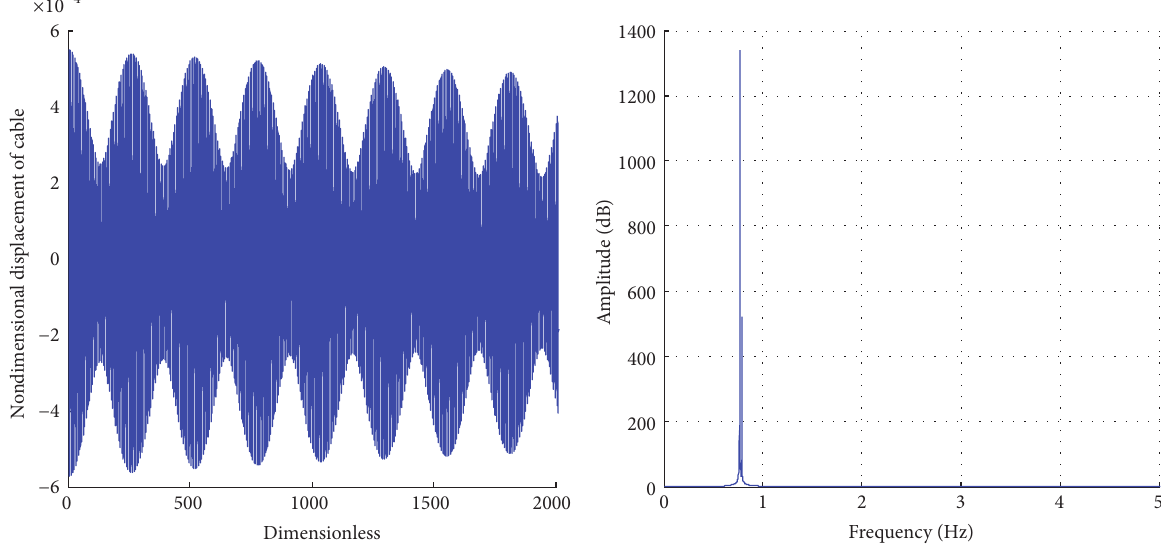
Figure 6: Dimensionless displacement response time history and amplitude-frequency characteristic curve of the cable midspan.